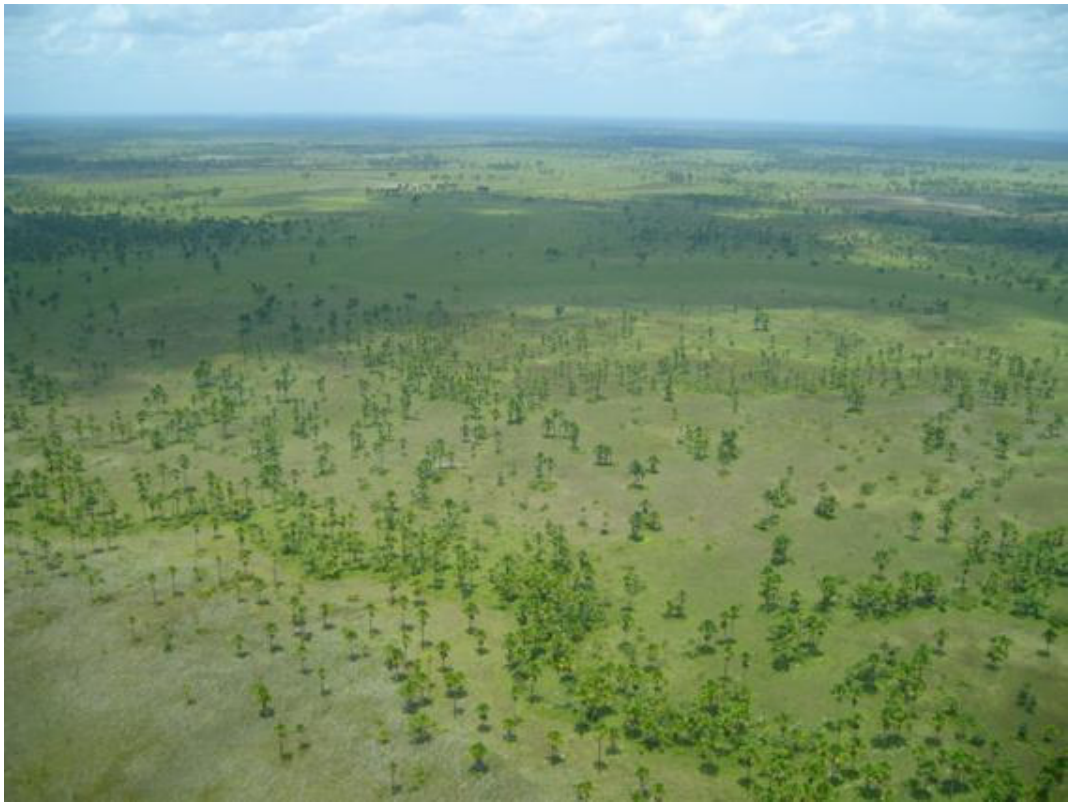
Figure 3. A miriti ( Mauritia flexuosa ) forest, aerial view, southeastern Marajó Island. Photograph by Denise Schaan,